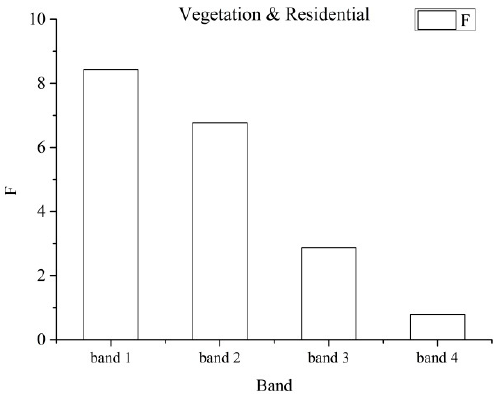
Figure 9. Comparison of differences in the mean grey value of each band for vegetation and residential land.